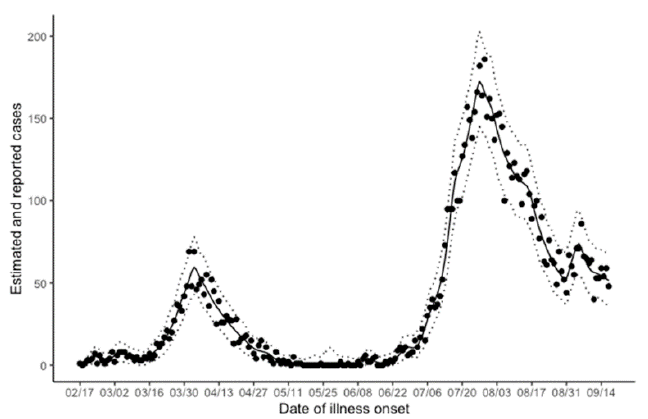
Figure 2. Comparison between the observed and model-predicted incidence of coronavirus disease 2019 (COVID-19) in Osaka prefecture. Comparisons were made as a function of the date of illness onset. Solid circles represent observed cases, while the continuous black line shows the maximum likelihood estimate of predicted incidence. Dotted lines represent the lower and upper boundaries of the 95% confidence intervals based on the bootstrap